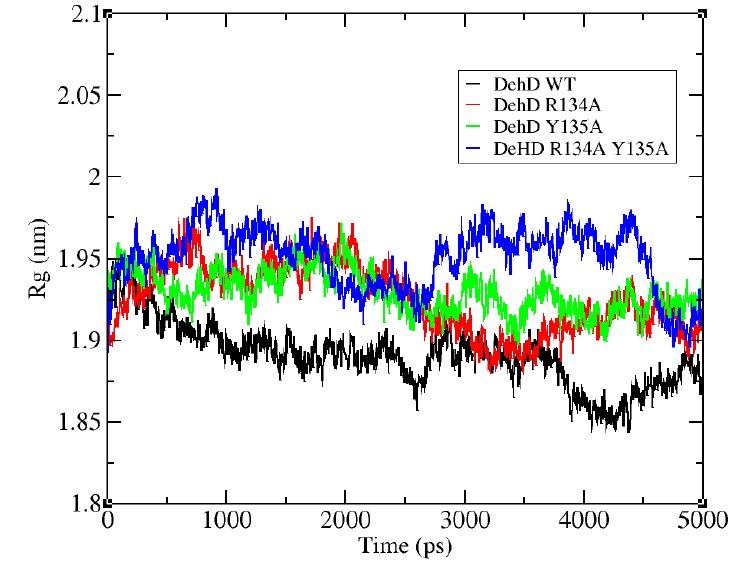
Figure 7. The radius of gyration of DehD compared with its variants. ( i ) black is DehD wild-type (DehD WT). ( ii ) red is the R134A mutant. ( iii ) green is the Y135A mutant. ( iv ) blue is the double substitution R134A/Y135A